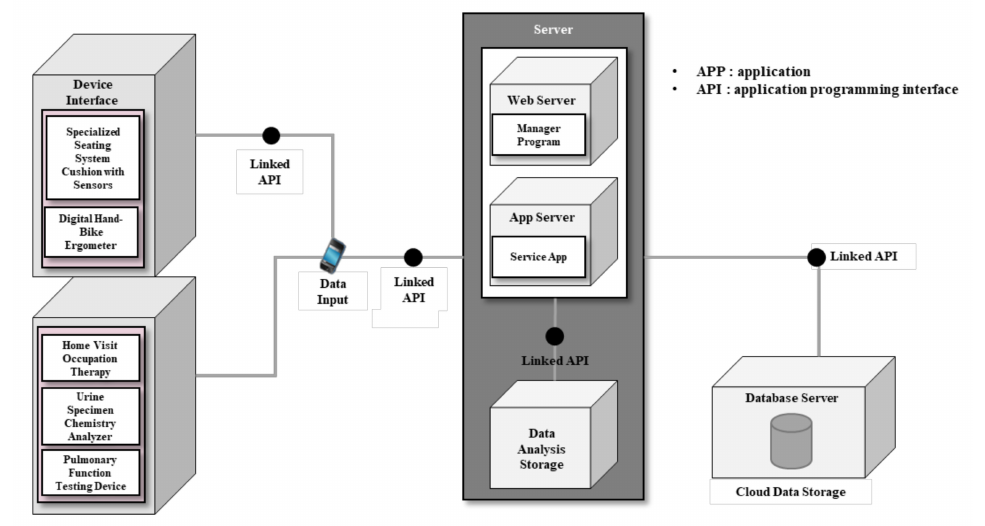
Figure 2. System concept diagram.